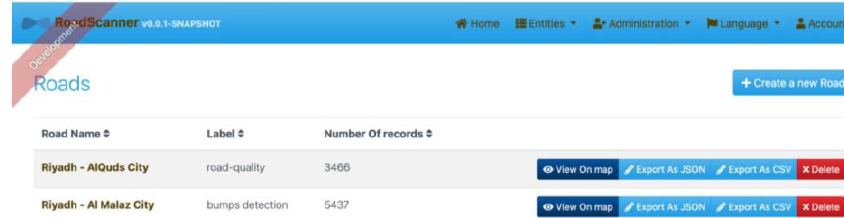
Figure 4. List of recordings from the web interface of the App.